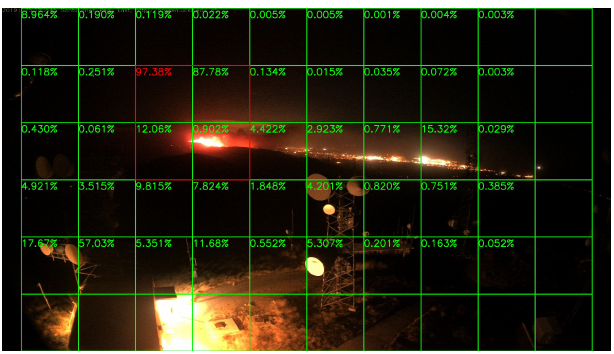
Figure 15. CaveFire, 25 November